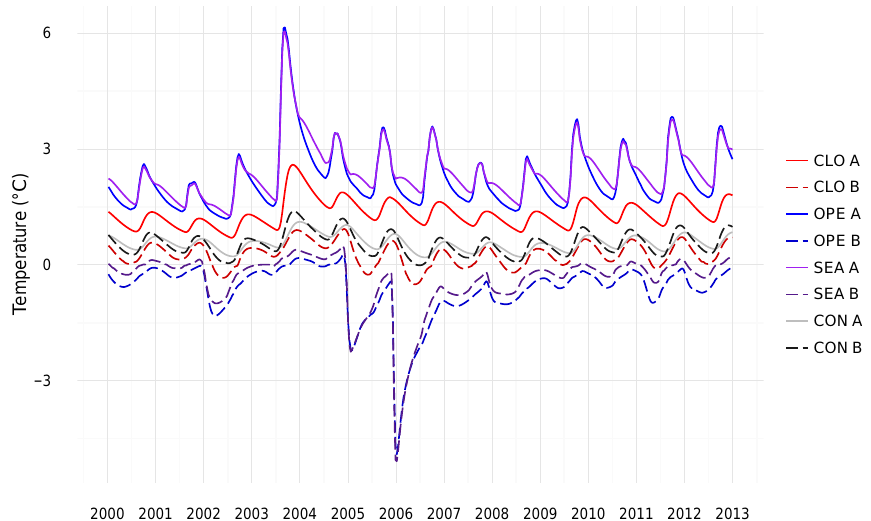
Figure 6. Temperature evolution at two different locations in the upper (node A, solid lines; see Fig. 2) and lower (node B, dashed lines; see Fig. 2) part of the talus slope for the CLO (red), the OPE (blue), the SEA (purple) and the CON (black)